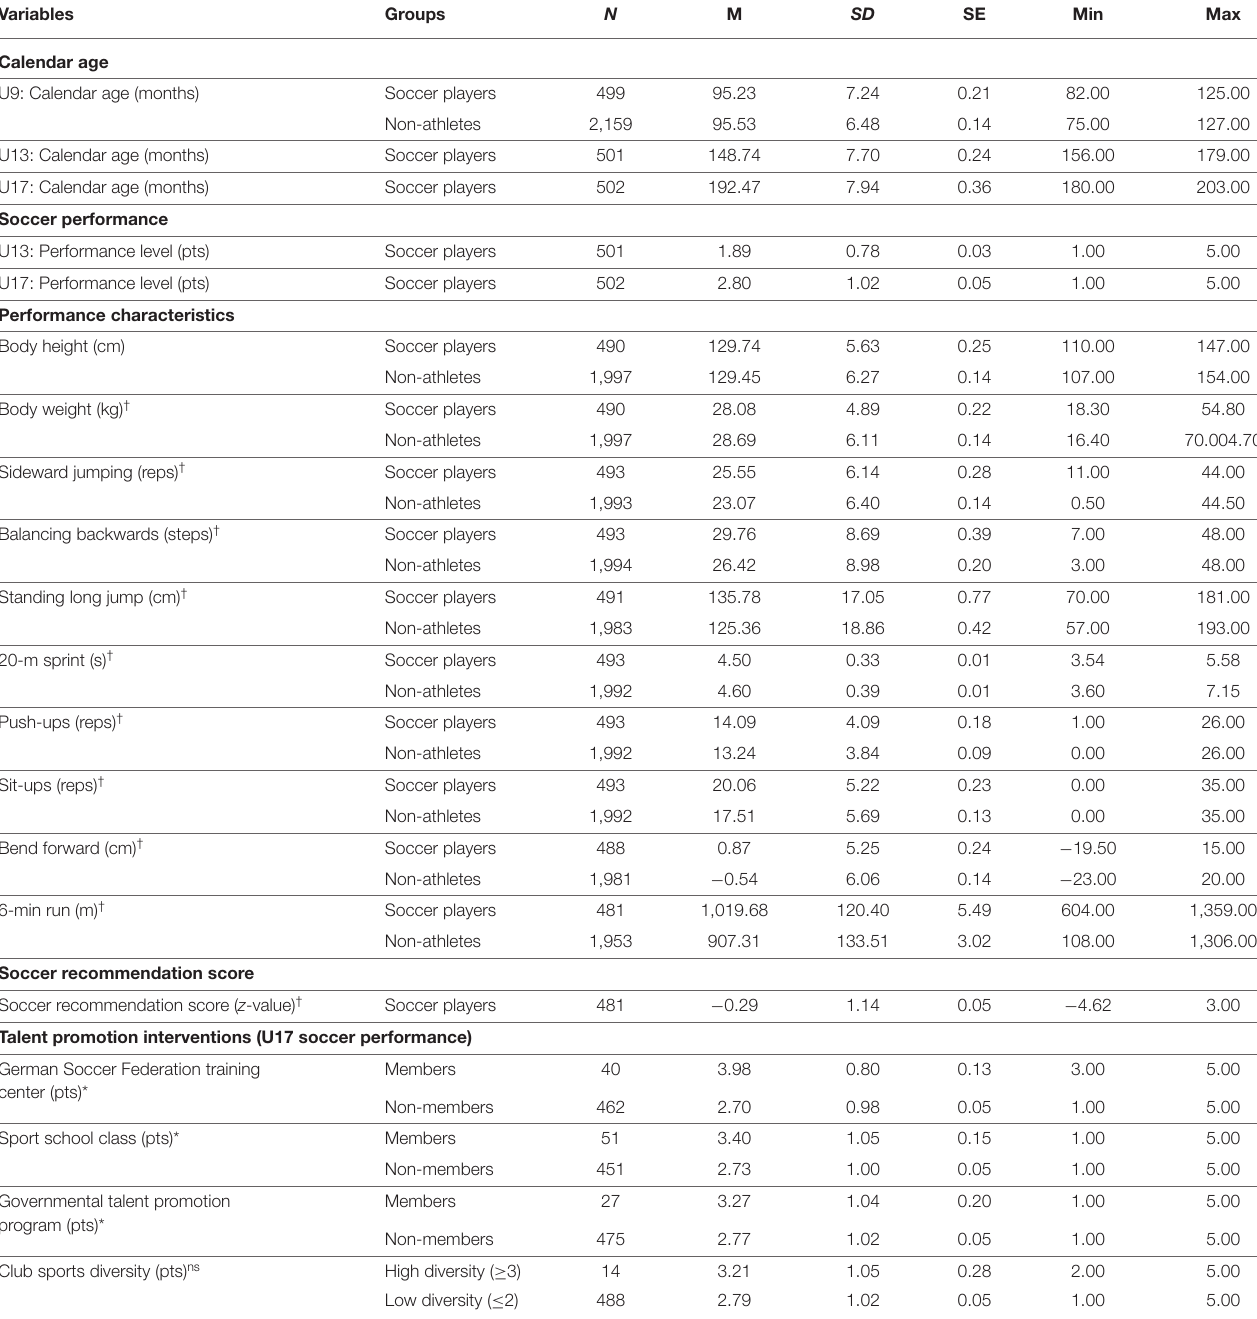
TABLE 2 | Descriptive statistics of age, soccer competition performances, two anthropometric, and eight motor diagnostics, soccer recommendation score, and four different talent promotion interventions in second-grade children taking part in the test campaigns 2010–2014 and competing in youth soccer competitions later on in the age groups U13 and U17 until the end of the season